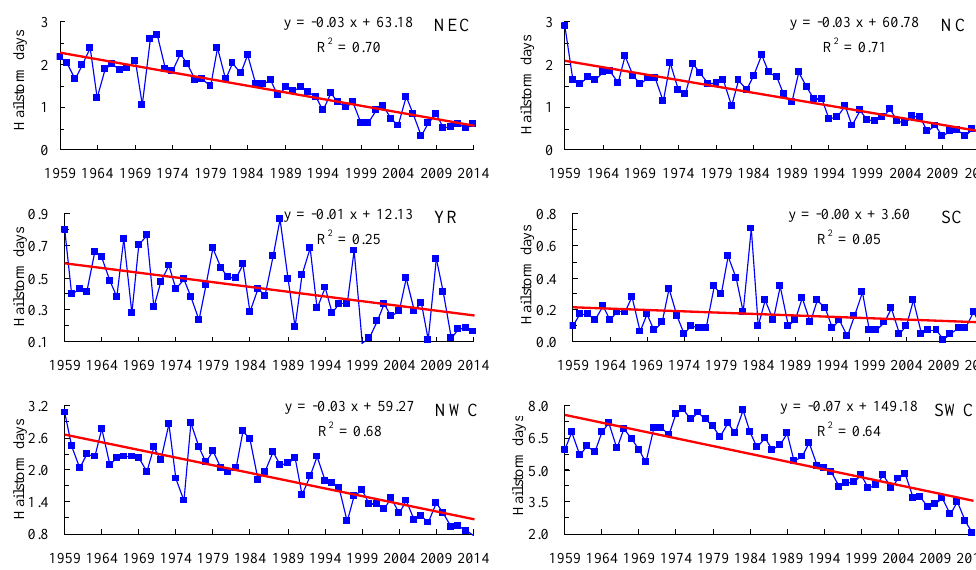
Figure 5. Variations of annual average hailstorm days in six regions of China during